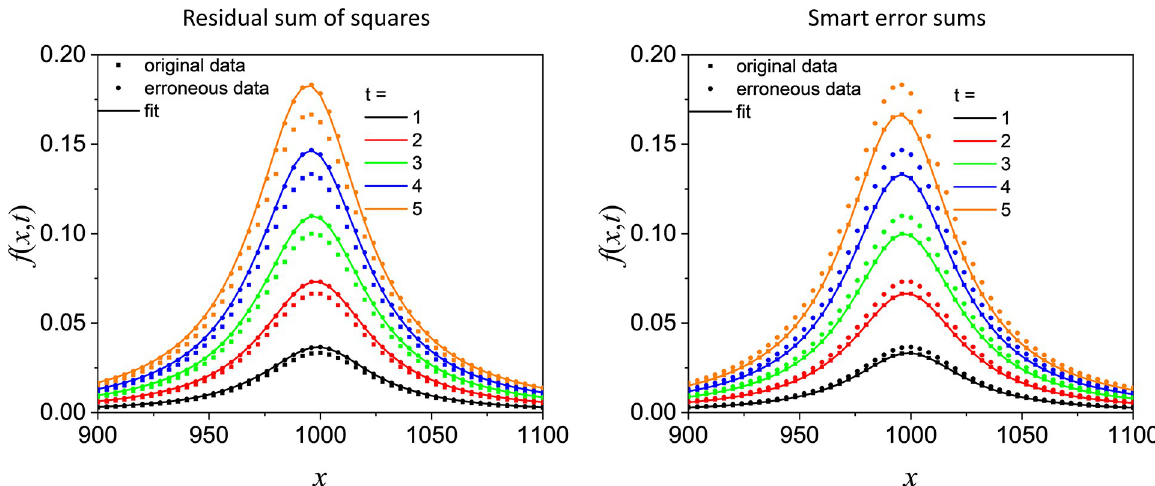
Fig 3. Comparison of performance for smart error sum and conventional error sum. Fit of the erroneous data with the conventional residual sum of squares (left panel) and with the smart error sums (right panel, the results obtained with the different error sums agree within line thickness except for Eq (18) if t 2 {1,3}).